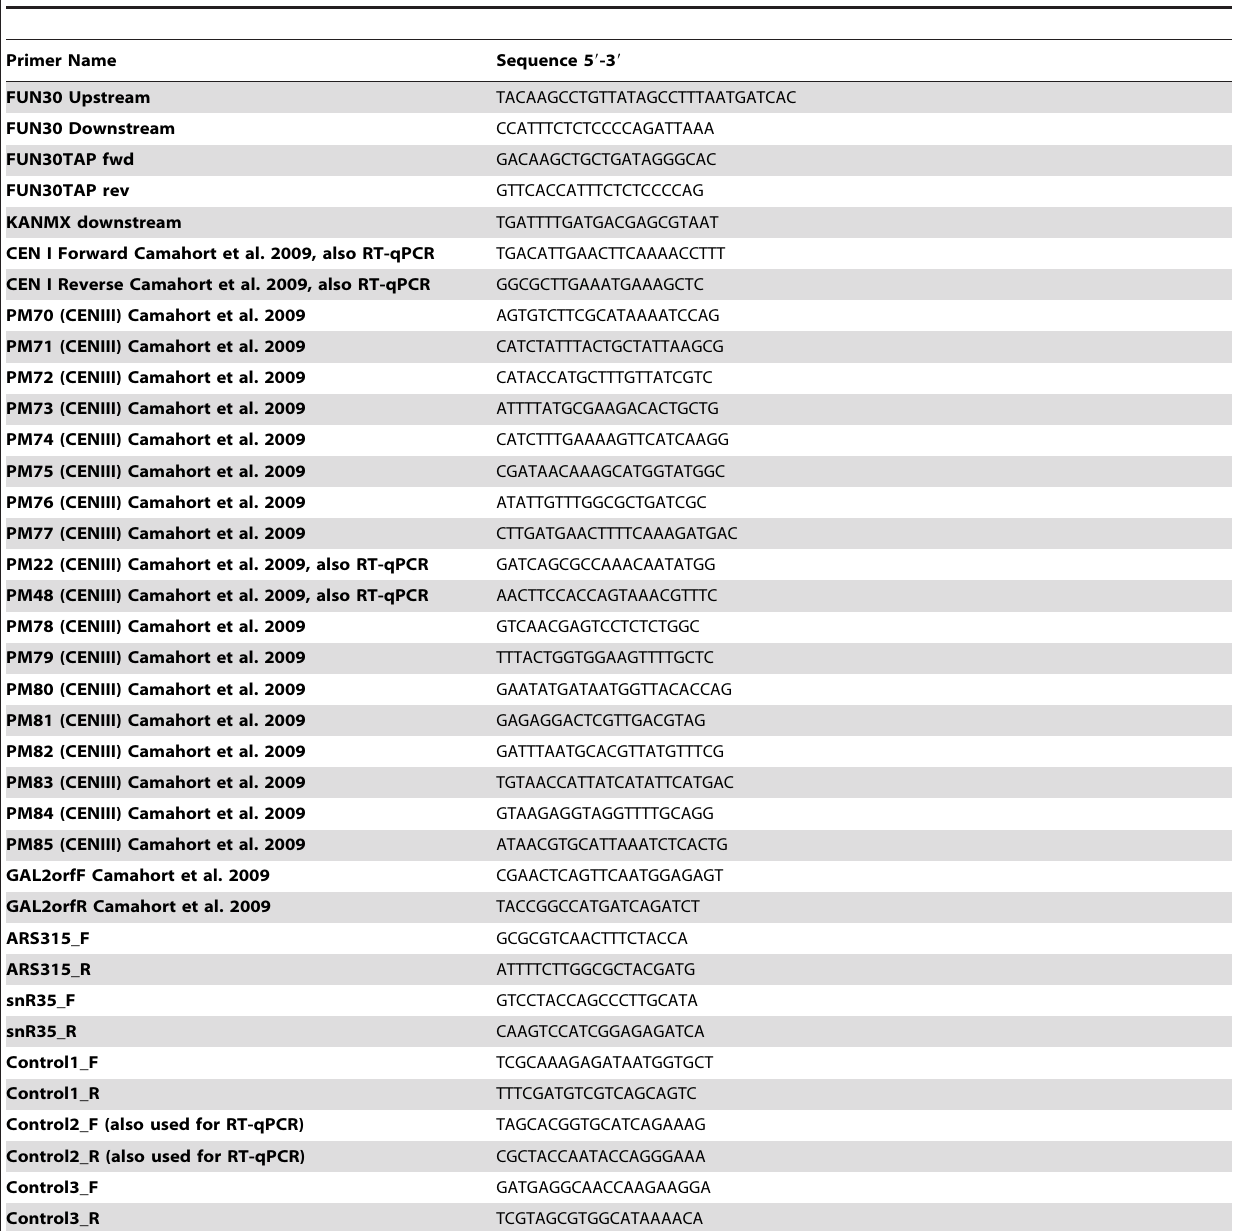
Table 3. Oligonucleotide primers used in this